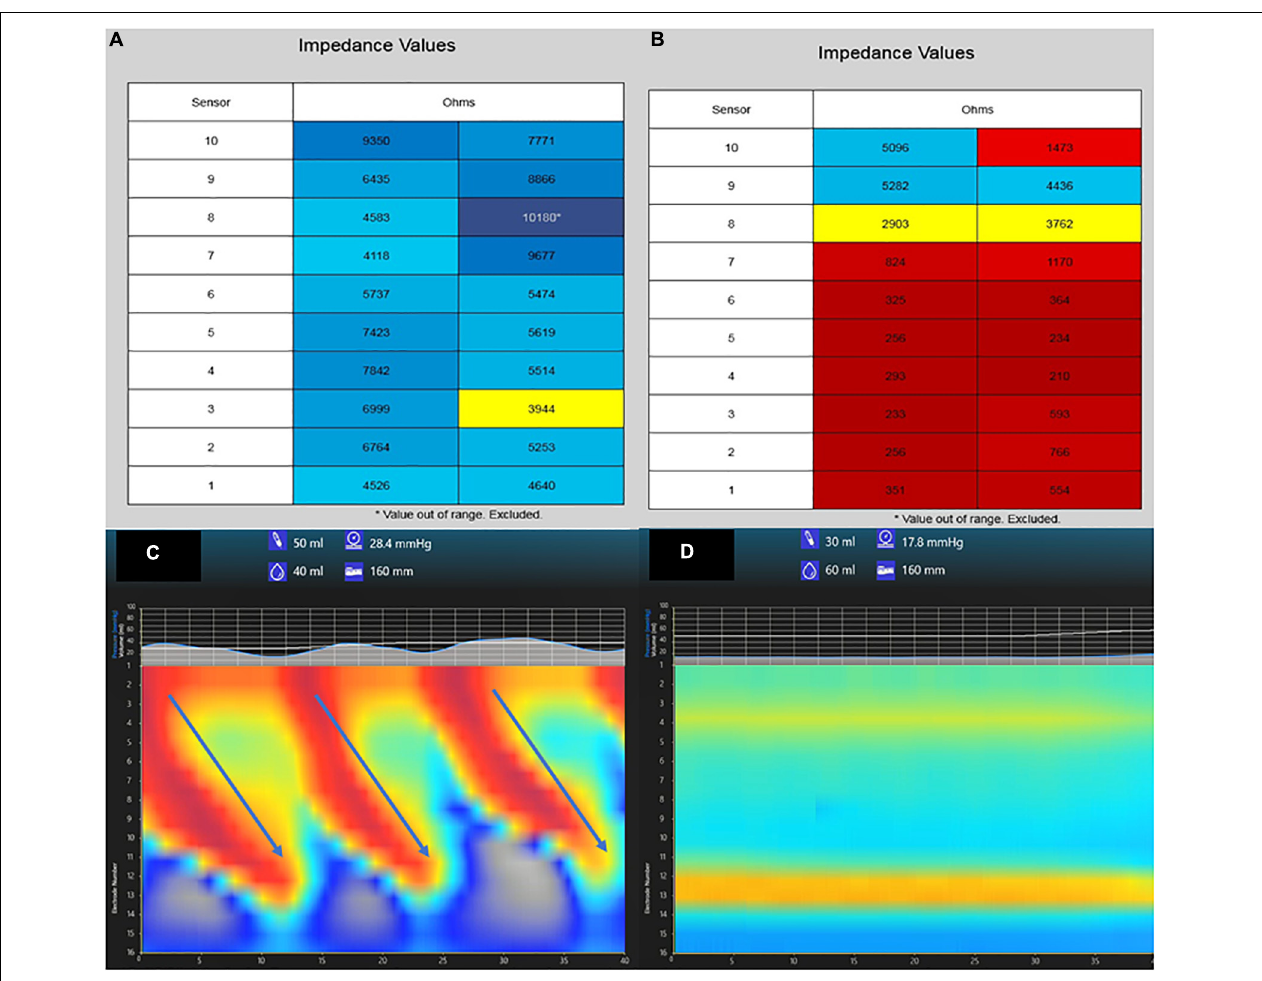
FIGURE 1 | Tracings from mucosal impedance and functional luminal imaging probe (FLIP) technology. A patient with normal esophageal mucosa has high impedance values ( > 3,000 ohms) at multiple esophageal levels shown in blue (A) , whereas a patient with pan-esophageal inflammation has low impedance values ( < 1,000 ohms) at multiple levels shown in red (B) . A FLIP tracing from a patient with normal secondary peristalsis and esophagogastric junction relaxation (C) shows repetitive antegrade contractions (RACs, arrows) whereas a patient with absent contractions show no RACs and absent EGJ relaxation (D)